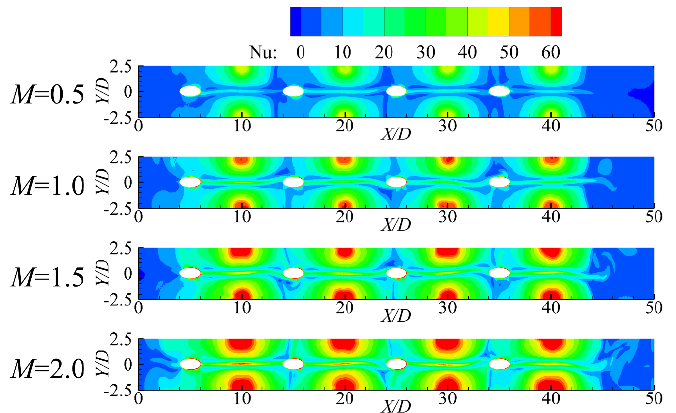
Figure 10. Contours of local Nusselt number on the internal surface of film plate with α = 30° at different values of M .